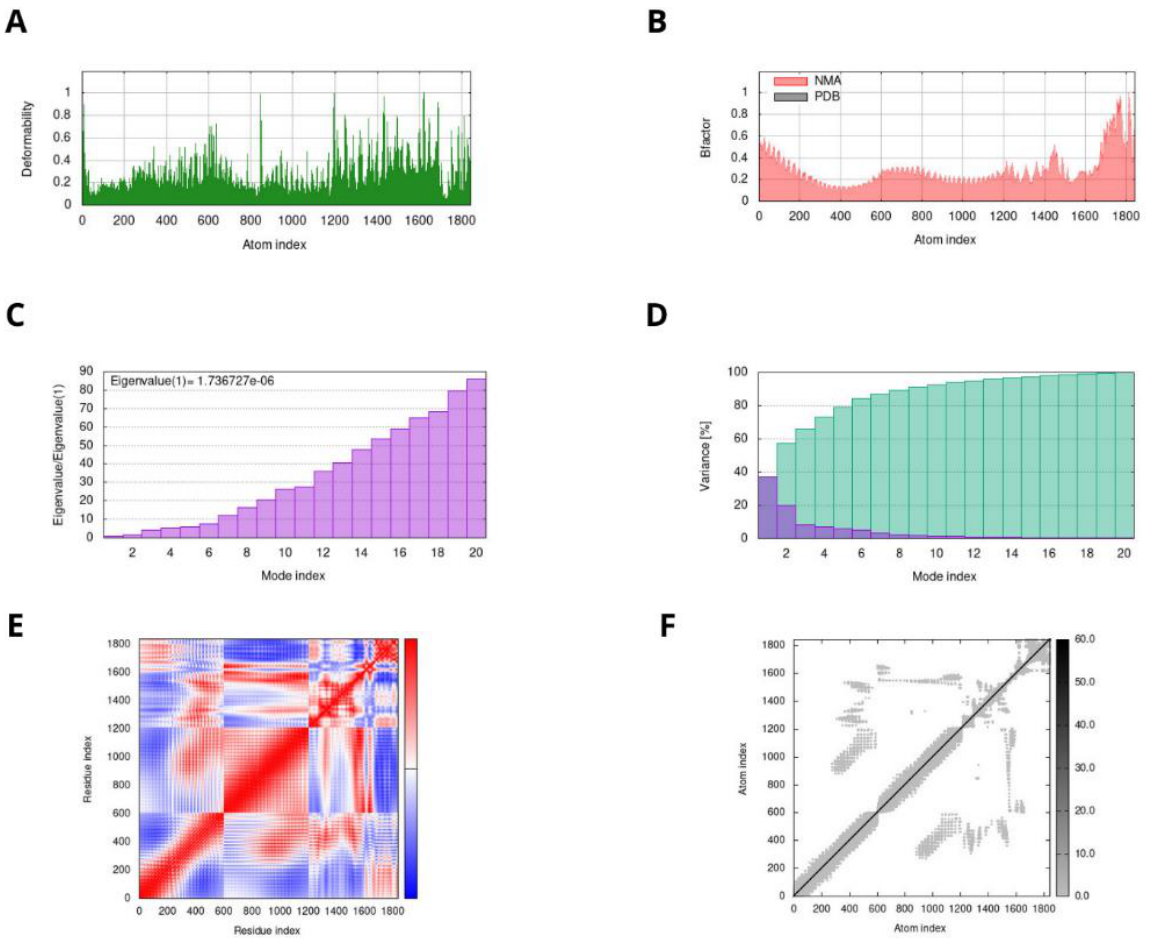
Figure 5. MD simulation results of peptide vaccine construct – TLR4 complex. The stability of the protein – protein complex was examined by: ( A ) deformability, ( B ) B-factor values, ( C ) eigenvalue, ( D ) variance, ( E ) covariance of residue index, and ( F ) elastic network analysis.